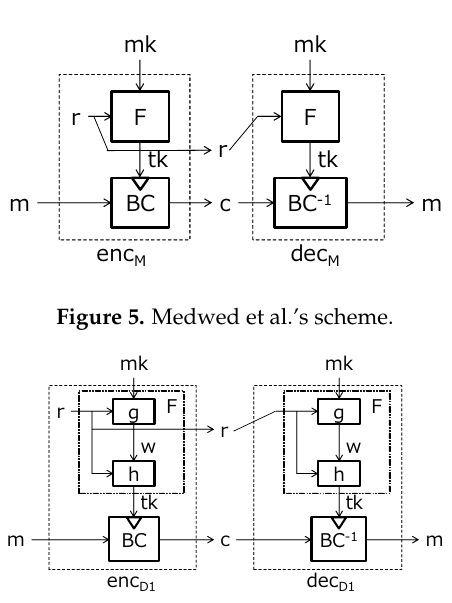
Figure 6. Dobraunig et al.’s first